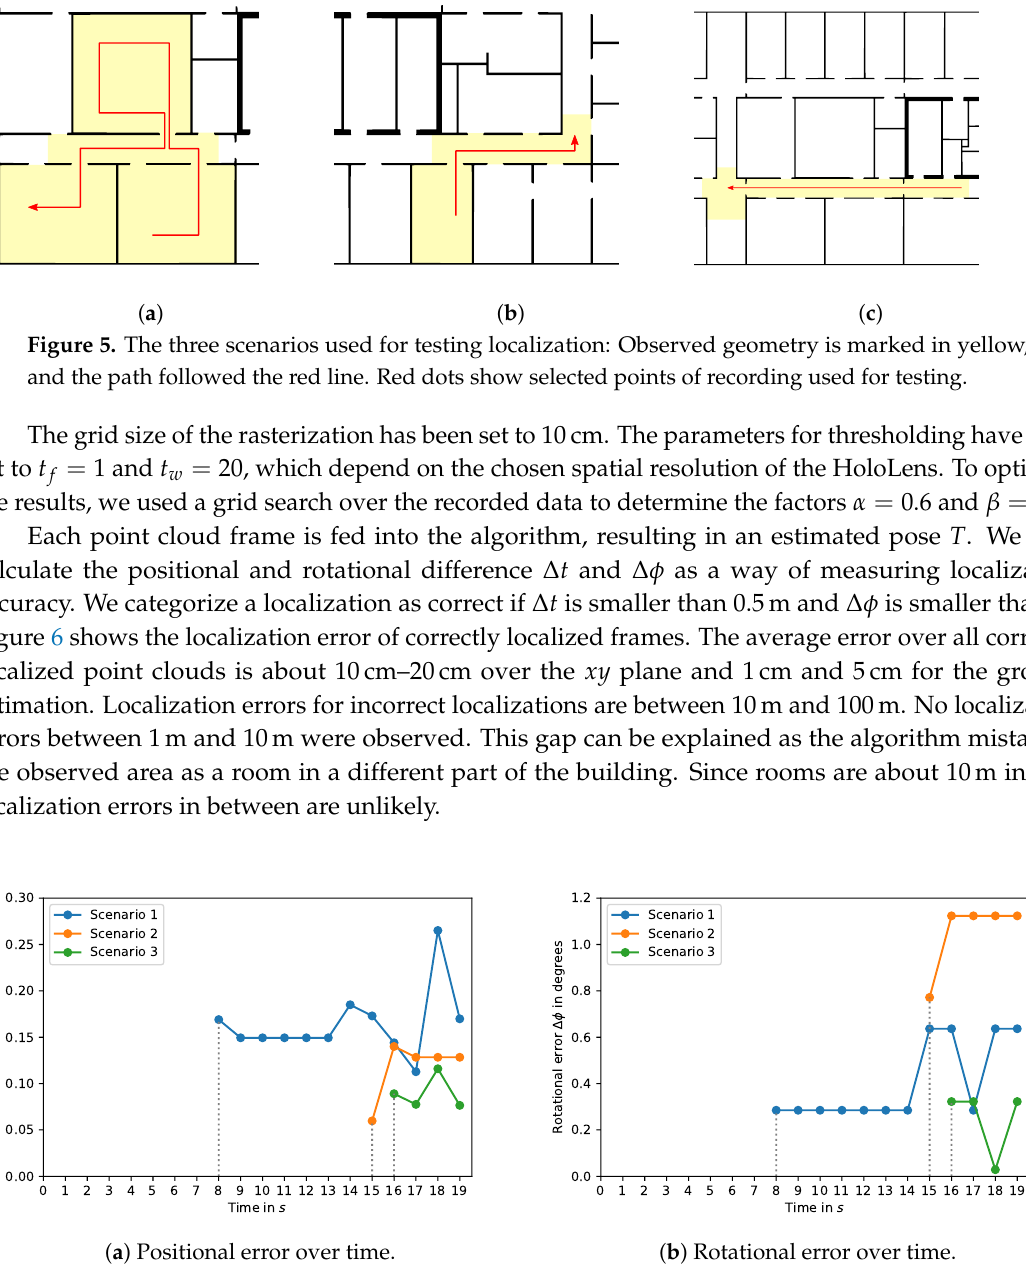
Figure 6. Localization error for position and rotation: The gray lines indicate the point in time when the first correct localization was measured. Localization results above 0.5m and 5 ◦ have been omitted from the